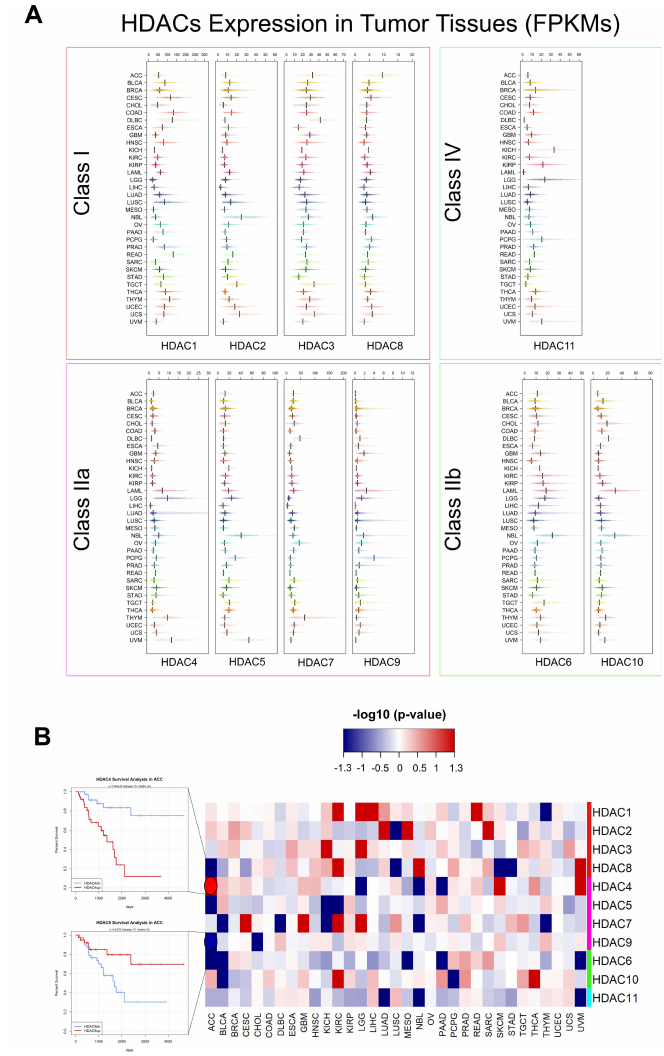
Figure 6. ( A ) Transcript levels of HDACs 1–11 in tumor tissues expressed in FPKM. Boxplots shows the expression of Class I (red box), Class IIa (pink box), Class IIb (green box), and Class IV (aquamarine box) from tumor samples in the pan-cancer TCGA dataset [187]. Tumor types are: ACC, adrenocortical carcinoma; BLCA, bladder urothelial carcinoma; BRCA, breast invasive carcinoma; CESC, cervical squamous cell carcinoma and endocervical adenocarcinoma; CHOL, cholangiocarcinoma; COAD, colon adenocarcinoma; DLBC, lymphoid neoplasm di ff use large B-cell lymphoma; ESCA, esophageal carcinoma; GBM, glioblastoma multiforme; HNSC, head and neck squamous cell carcinoma; KICH, kidney chromophobe; KIRC, kidney renal clear cell carcinoma; KIRP, kidney renal papillary cell carcinoma; LAML, acute myeloid leukemia; LGG, brain lower grade glioma; LIHC, liver hepatocellular carcinoma; LUAD, lung adenocarcinoma; LUSC, lung squamous cell carcinoma; MESO, mesothelioma; OV, ovarian serous cystadenocarcinoma; NBL, TARGET-neuroblastoma [188]; PAAD, pancreatic adenocarcinoma; PCPG, pheochromocytoma and paraganglioma; PRAD, prostate adenocarcinoma; READ, rectum adenocarcinoma; SARC, sarcoma; SKCM, skin cutaneous melanoma; STAD, stomach adenocarcinoma; TGCT, testicular germ cell tumors; THYM, thymoma; THCA, thyroid carcinoma; UCS, uterine carcinosarcoma; UCEC, uterine corpus endometrial carcinoma, UVM, uveal melanoma. Expression was FPKM-normalized using the length of ENSEMBL longest isoform and RNA-Seq data from TCGA. ( B ) Integrated HDAC survival analysis across tumors. Color intensity in the heatmap is proportional to -log10(p-value), a threshold of | 1.3 | corresponds to a p -value = 0.05. Red boxes in the heatmap correspond to a worse OS when the corresponding HDAC is upregulated, while blue boxes mean a better OS in case of upregulation, as shown by example survival curves (left